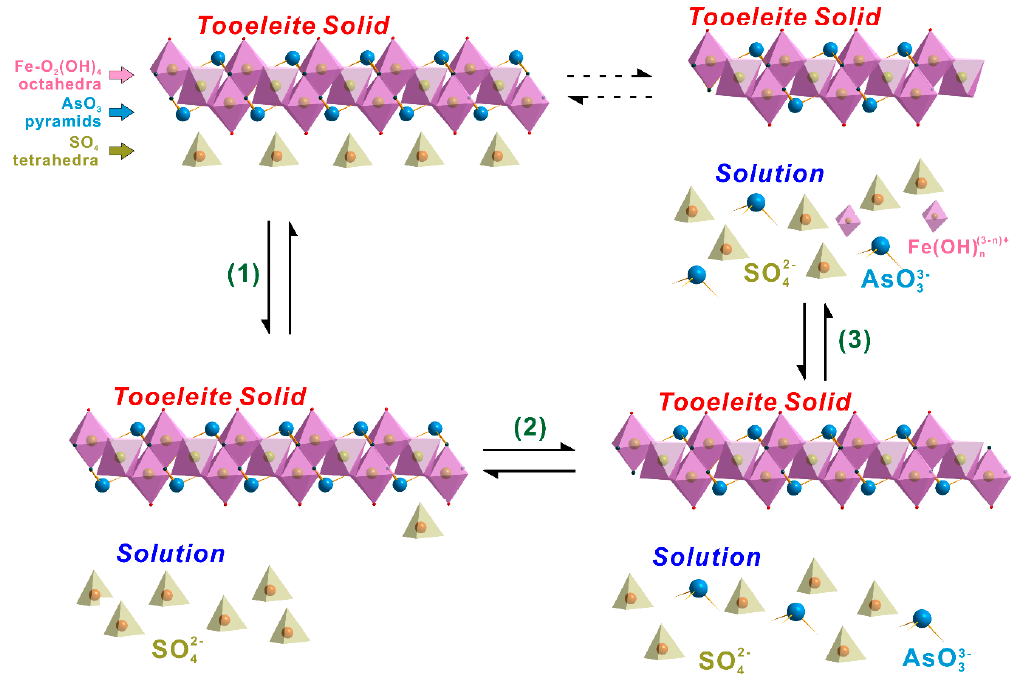
Figure 5. Dissolution mechanism of tooeleite in aqueous solution.